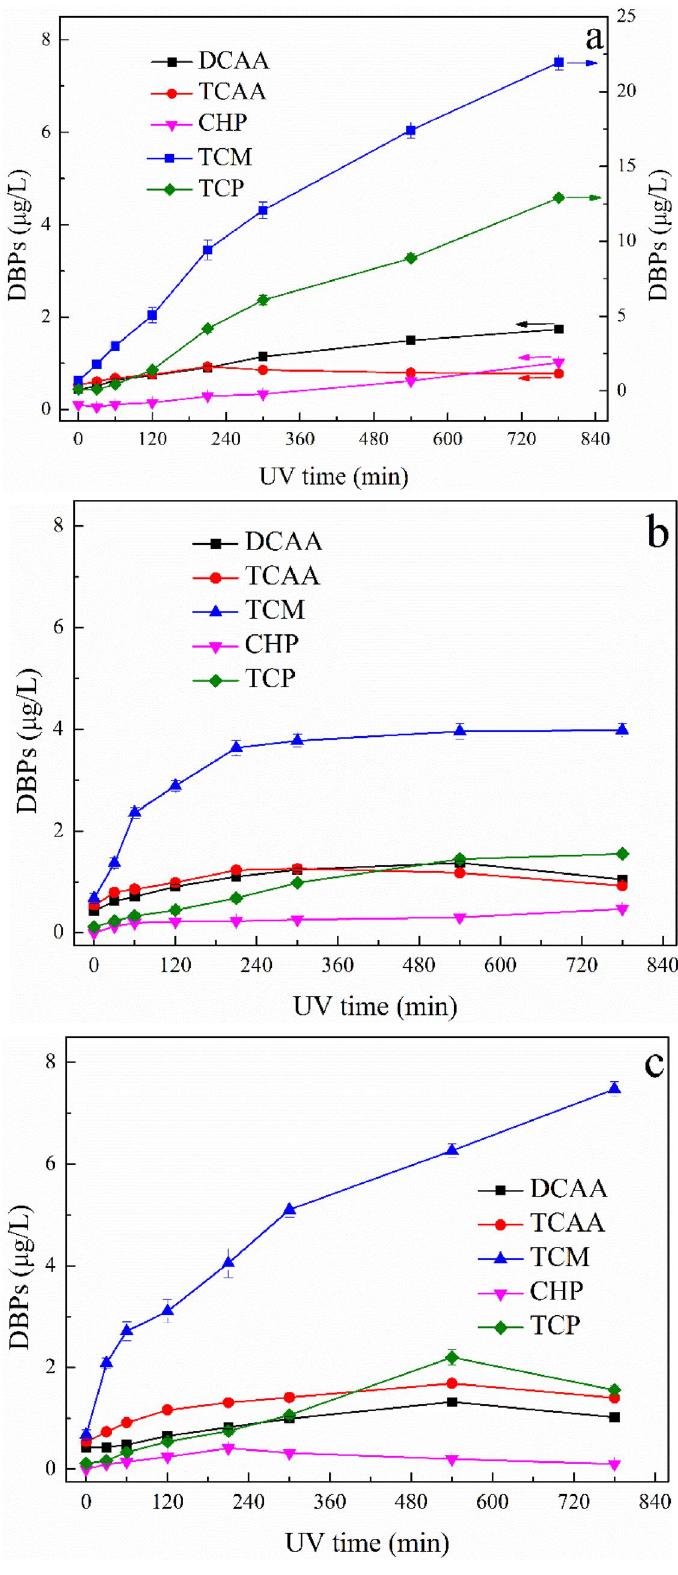
Figure 9. DBPs formations of UV oxidized ATZ solutions: ( a ) pH = 4.0; ( b ) pH = 7.0; (c) pH =